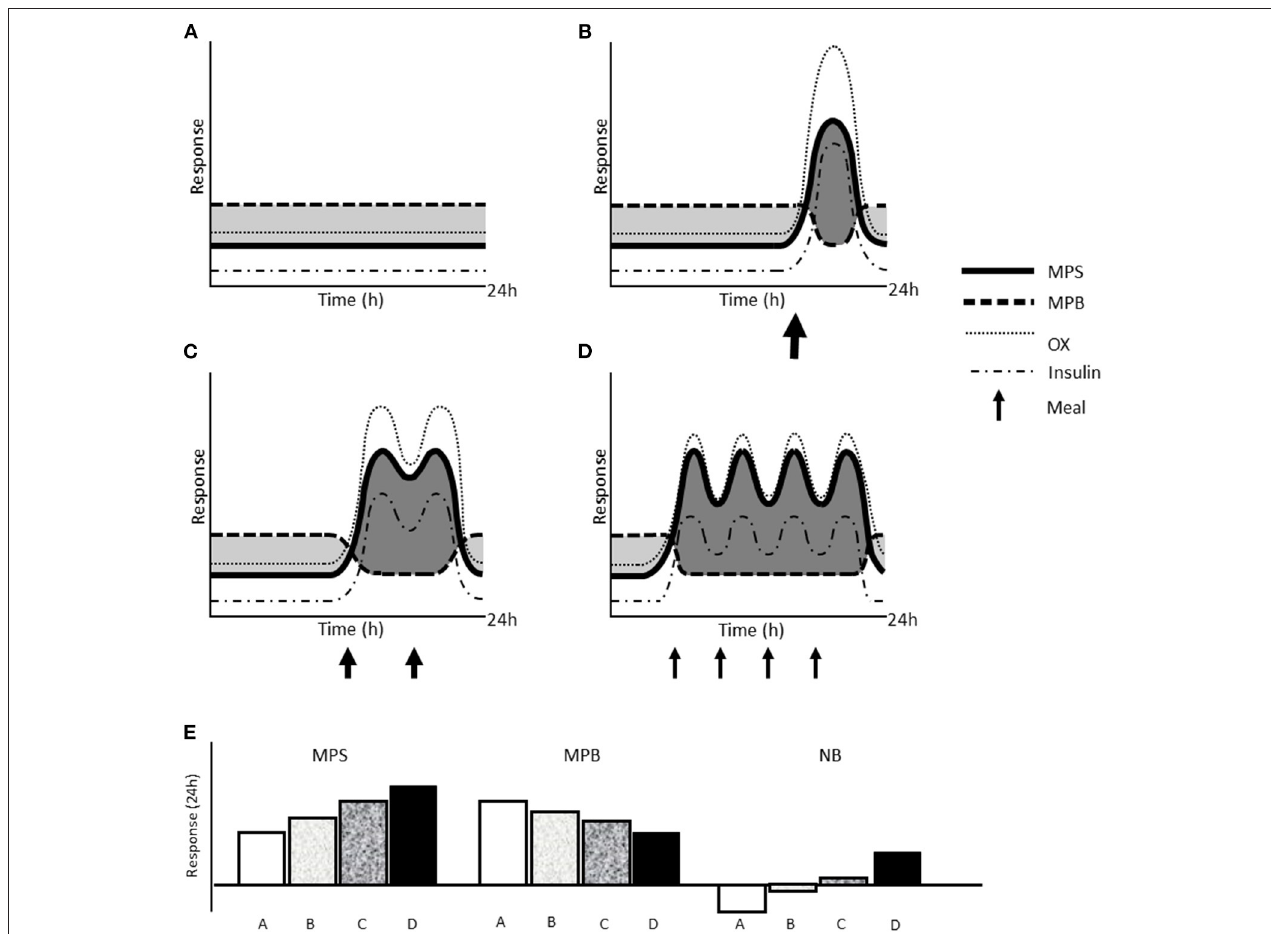
FIGURE 1 | Schematic representation of the effect of different types of IF on acute muscle protein kinetics. Changes in muscle protein synthesis (MPS) and breakdown, amino acid oxidation (OX), and circulating insulin concentration over 24h at rest with whole day fasting (A) , TRE with one meal (B) , TRE with two meals over 6–8h (C) , and an unrestricted eating window ( ∼ 16h) with balanced meal pattern (D) . Size of arrows reflects the relative protein and energy content of each meal. Shaded dark gray areas indicate time in net positive protein balance and light gray areas indicate time in net negative protein balance, which are summarized as net 24h response in MPS, MPB, and net muscle protein balance (NB; MPS—MPB) (E)